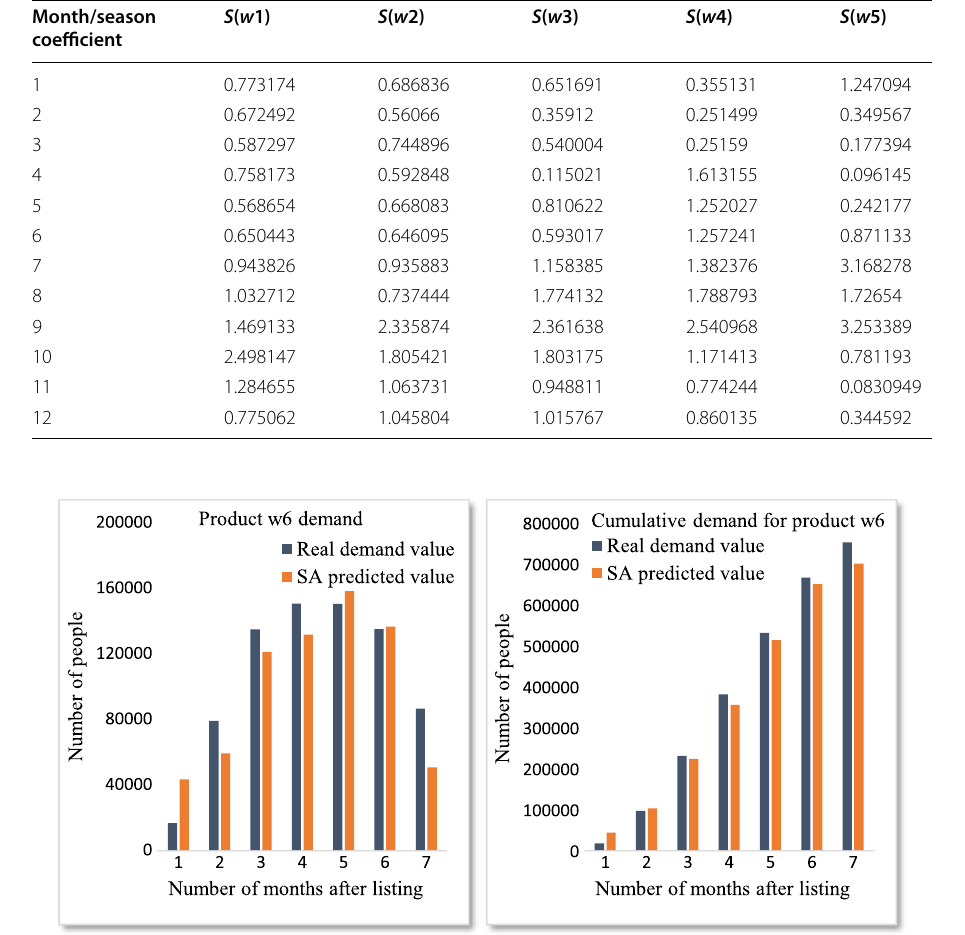
Table 1 Seasonal impact factors of five products